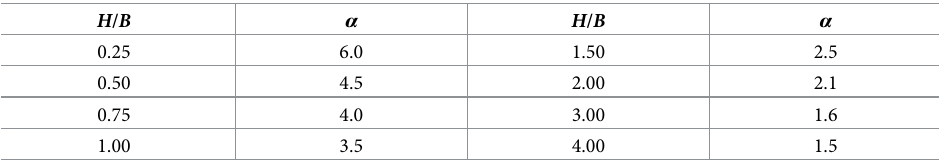
Table 1. Recommended values for α